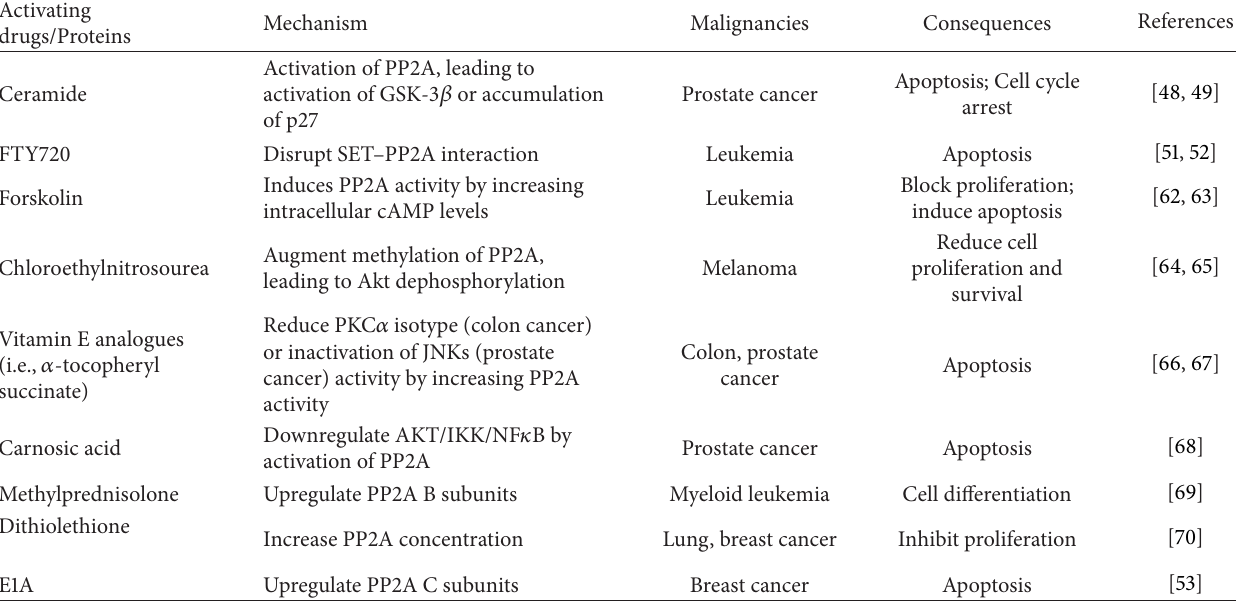
Table 4: PP2A-activating